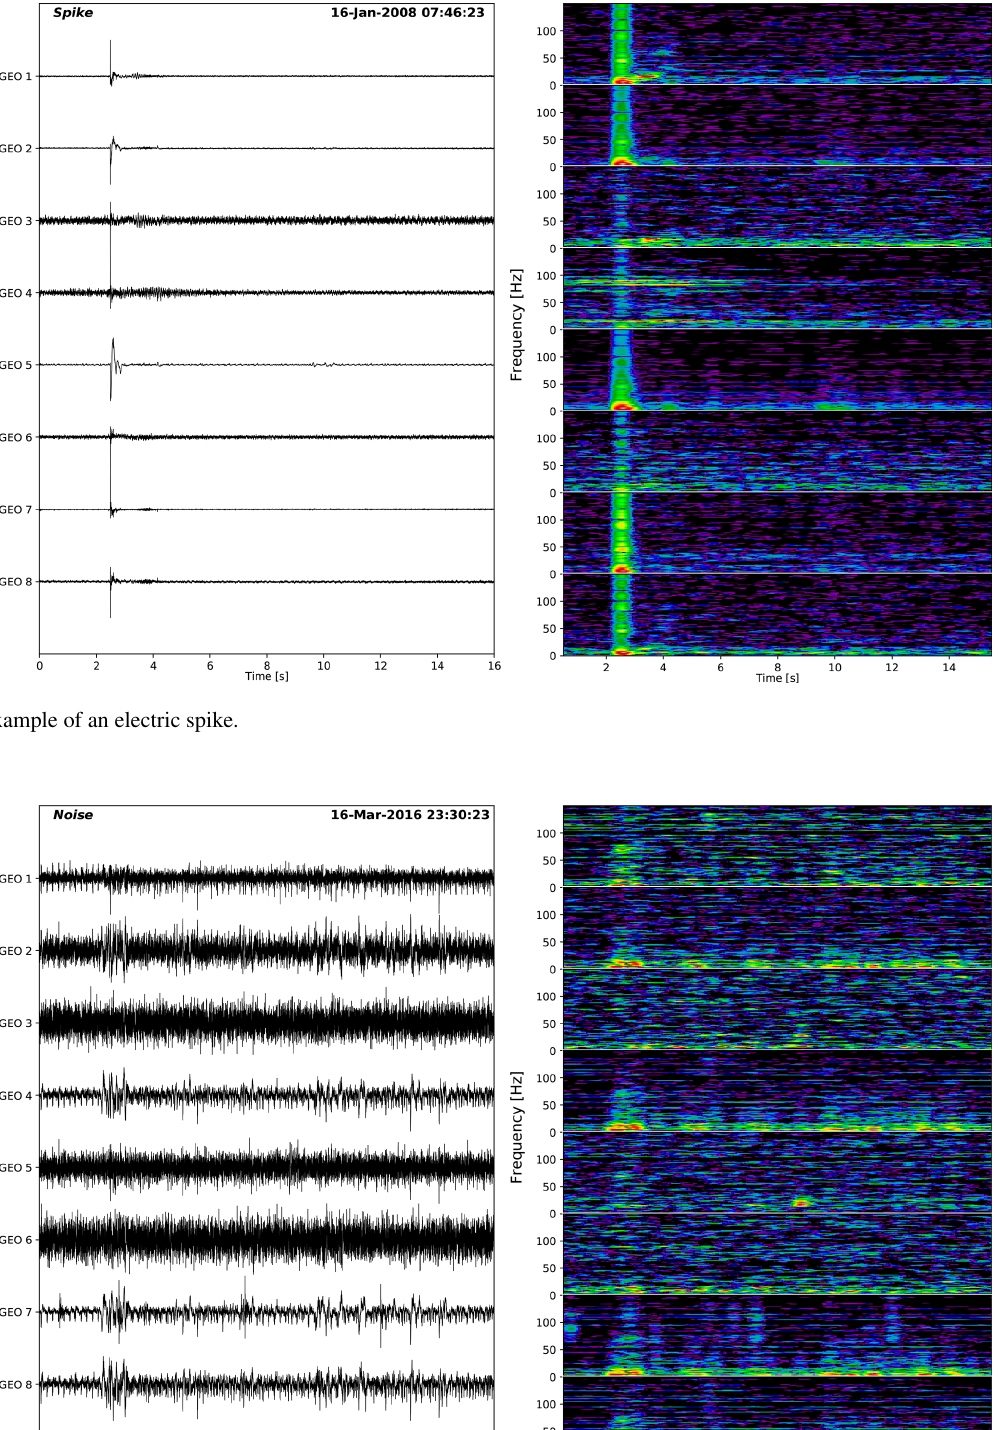
Earth Surf. Dynam., 11, 89–115, 2023